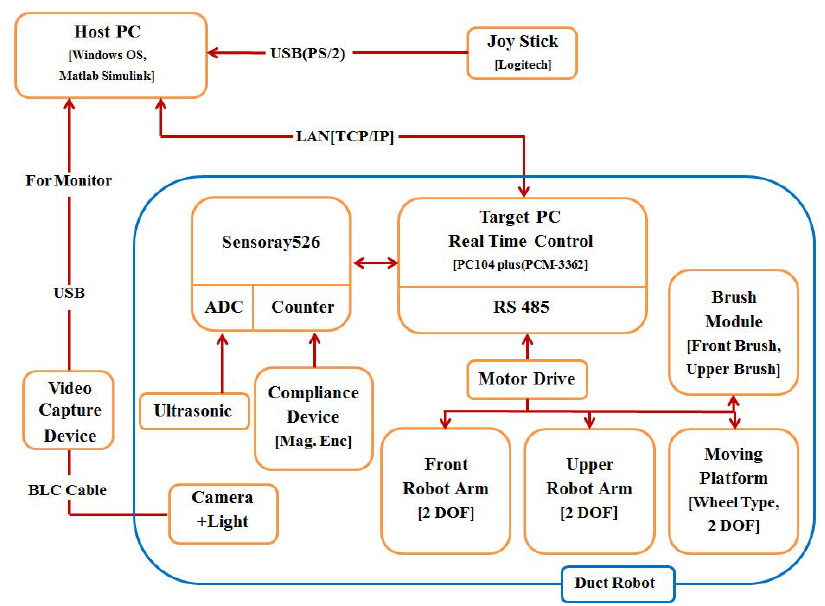
Figure 2. Control system diagram of the duct cleaning